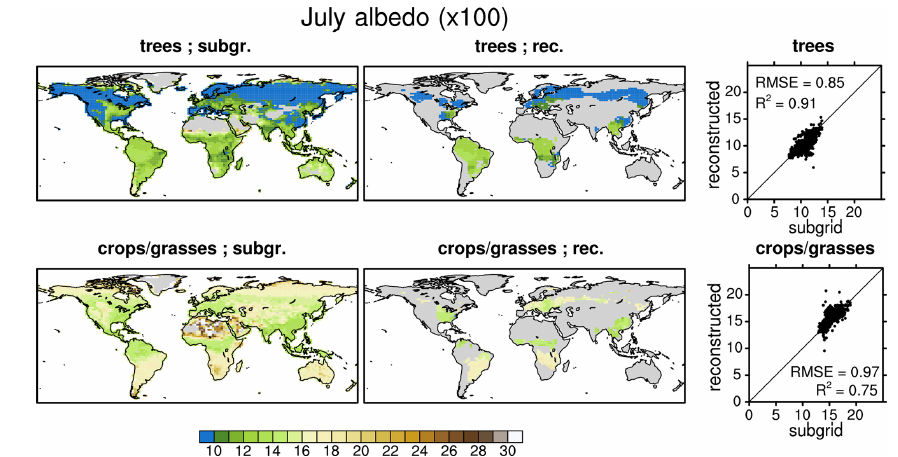
Figure 2. Sub-grid (left) and reconstructed (middle) estimates of the present-day (2002–2010) albedo of trees (upper row) and crops–grasses (lower row) in the CLM4.5 simulations for the month of July. The scatter plots (right) indicate the relationship between reconstructed ( y axis) and sub-grid estimates ( x axis), with each dot indicating the results of a grid cell for which both methods could be applied. Note that albedo values have been multiplied by 100 to facilitate readability.